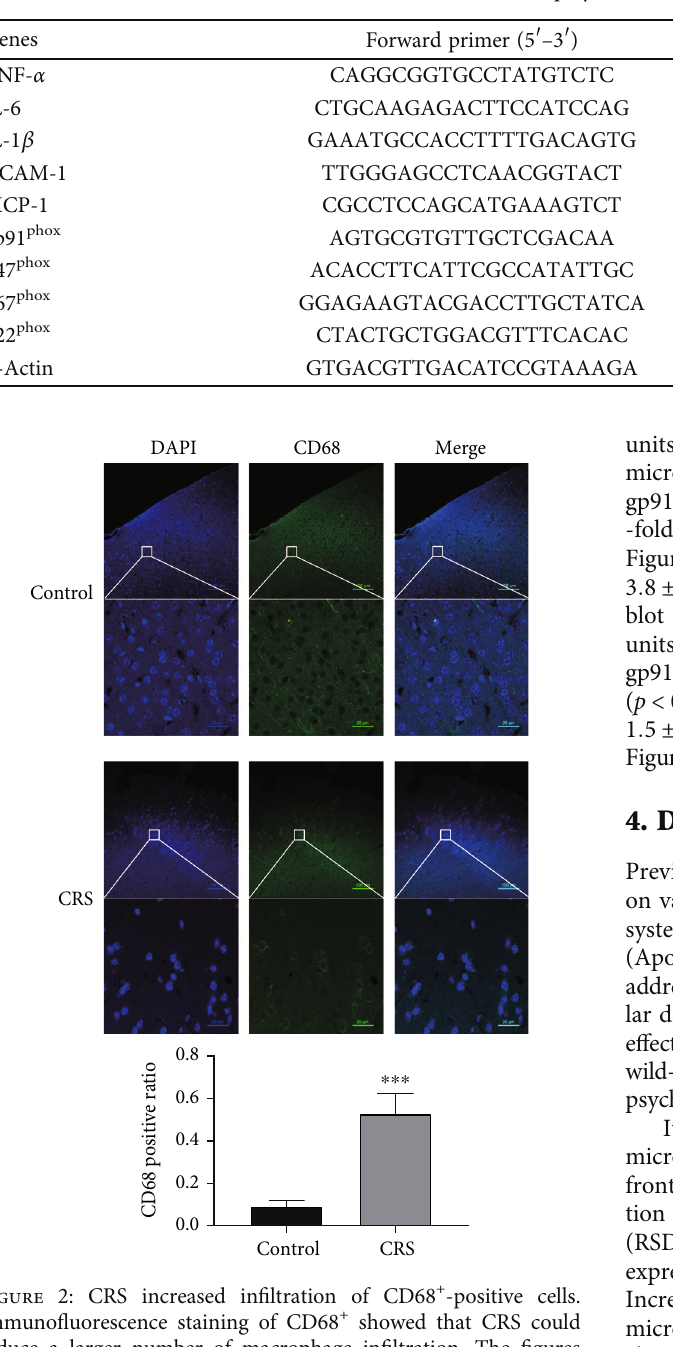
Table 1: Primers for real-time polymerase chain reaction (PCR) analysis.